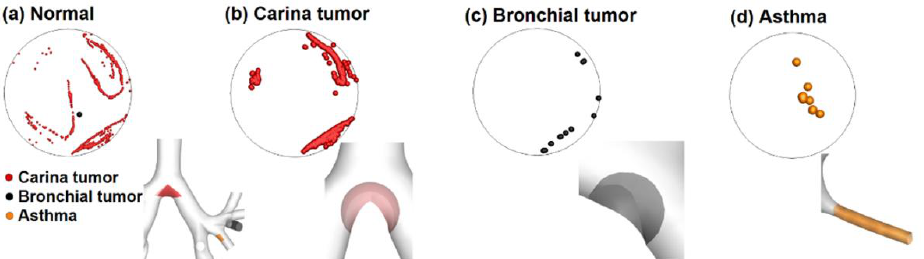
Figure 4. The release positions of aerosols that will deposit on the diseased regions: ( a ) normal, ( b ) carina tumor, ( c ) bronchial tumor, and ( d ) constricted bronchi (asthma). Adapted from [57].